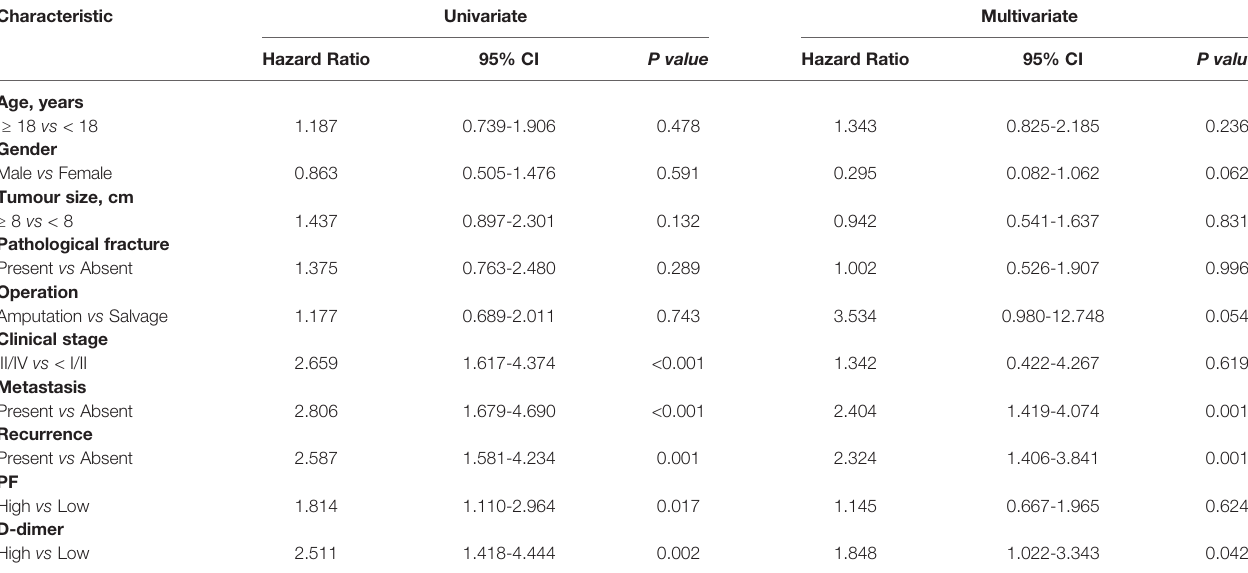
TABLE 3 | Univariate and multivariate analyses of PF and D-dimer expression in relation to PFS in patients with osteosarcoma. Characteristic